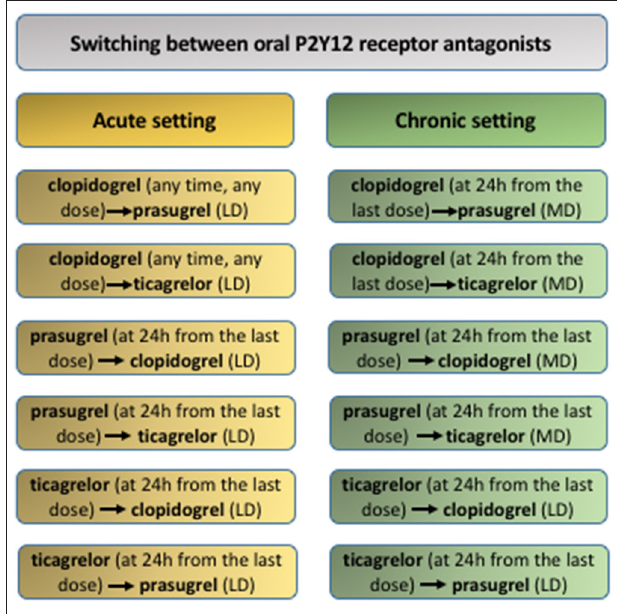
FIGURE 3 | Switching strategy between oral P2Y 12 receptor antagonists. LD, loading dose; clopidogrel LD = 600mg; prasugrel LD = 60mg; ticagrelor